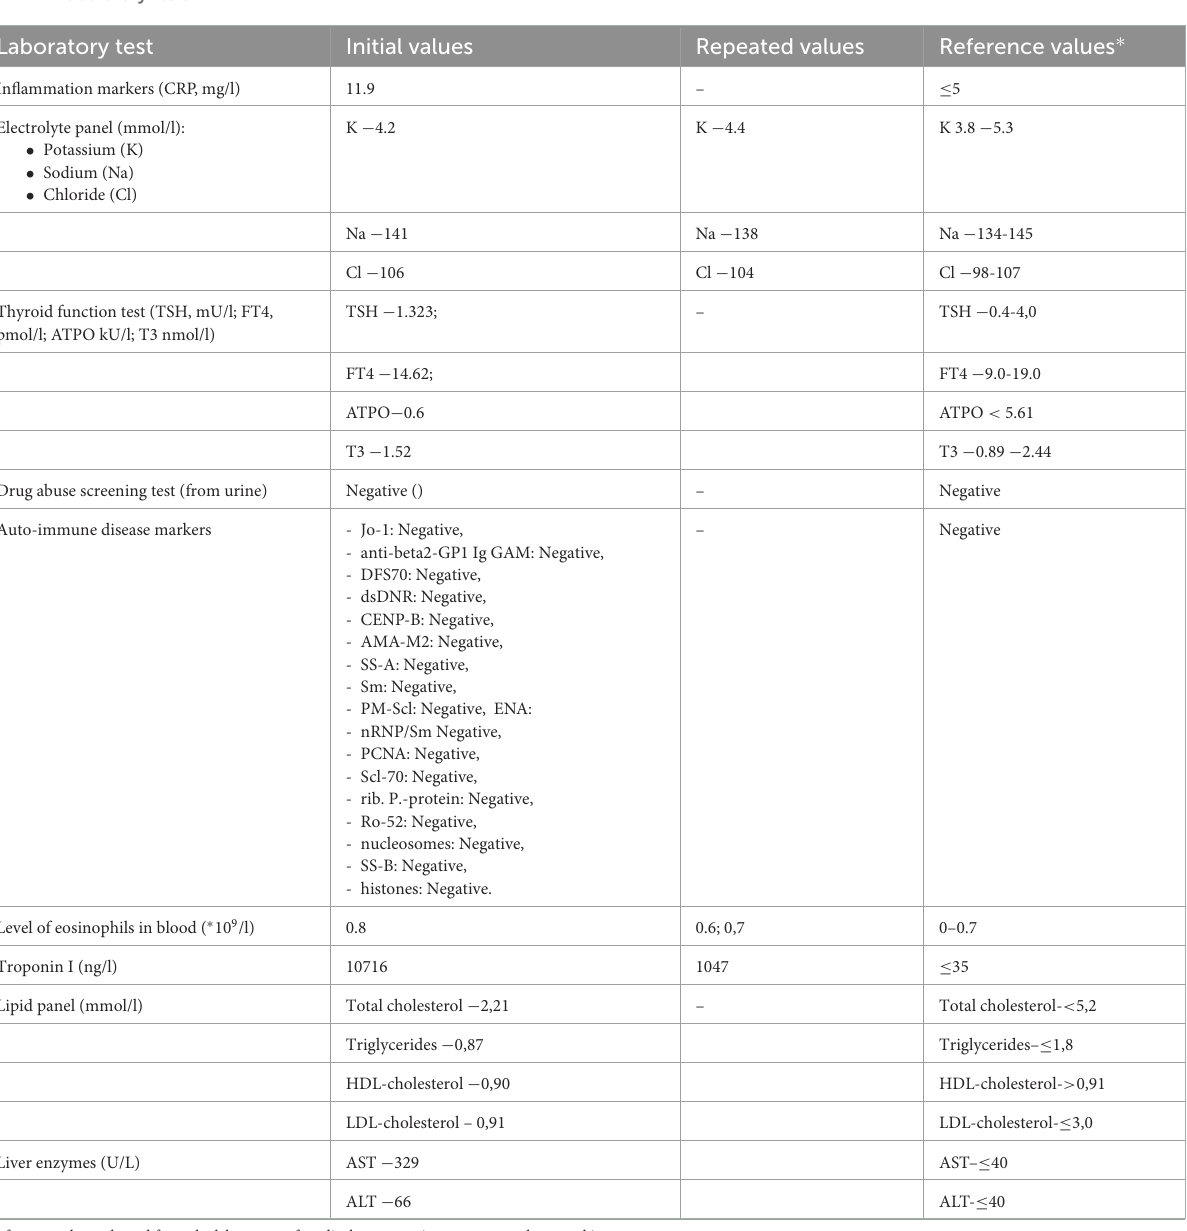
TABLE 2 Laboratory tests. Laboratory test Initial values Repeated values Inflammation markers (CRP, mg/l)